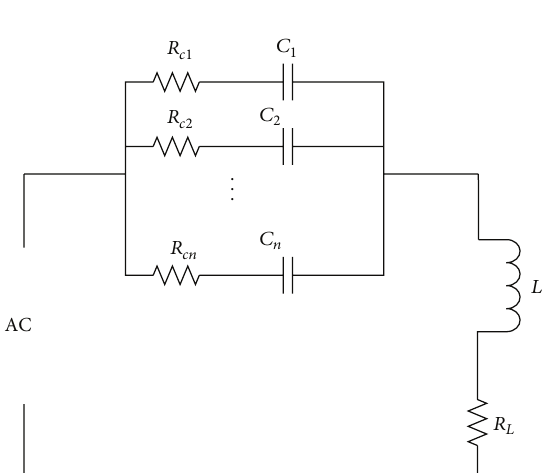
Figure 5: Circuit model for parallel connected capacitors.